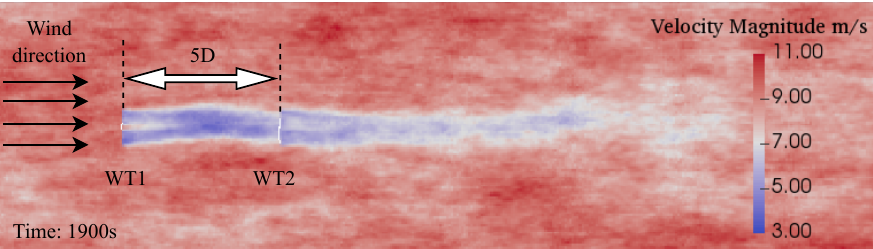
Figure 6. The 1900th second FAST.Farm simulation under precursor P7 and yaw offset ( θ 1 = 5 degree, θ 2 = 0